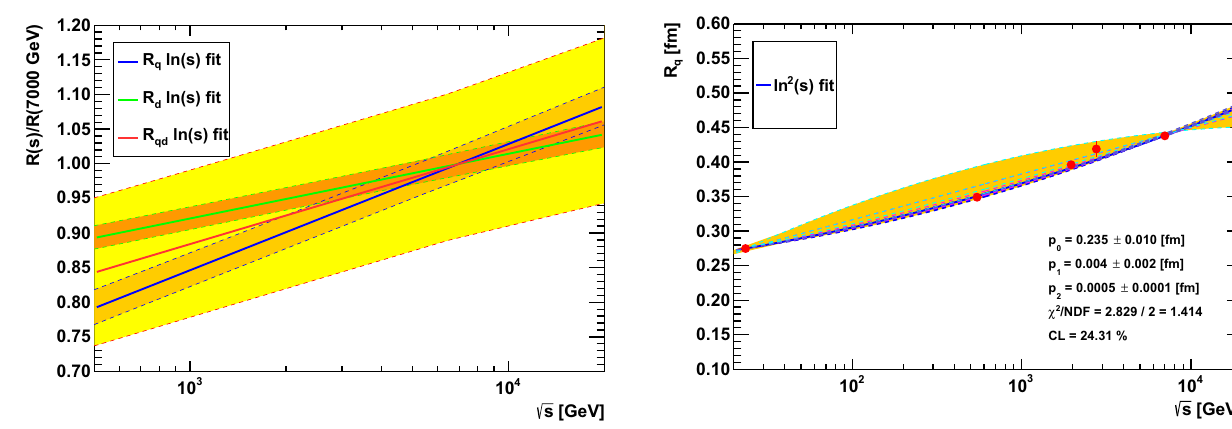
√ s = 2 . 76, 1 . 96 and 0 . 546 TeV. Hence we had to take